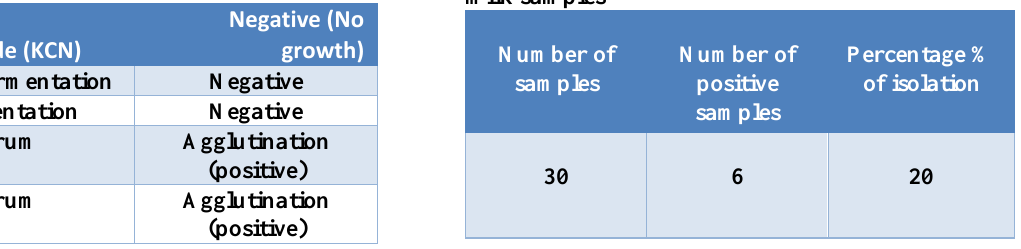
Table, 3: prevalence of E. coli O157:H7 from